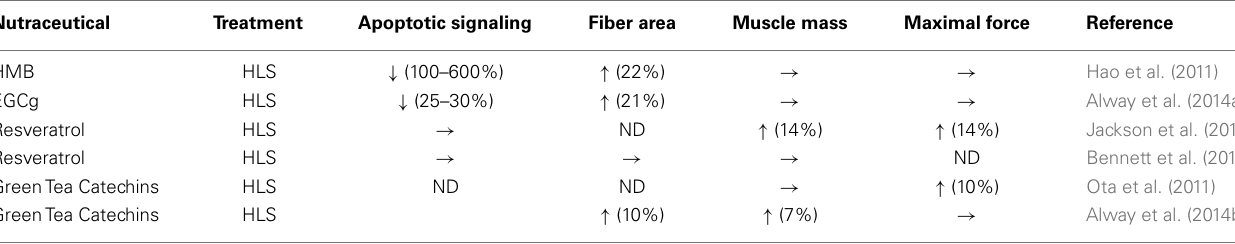
Table 1 | Summary of nutraceutical effect on apoptosis and muscle function in aging muscle during forced disuse . Nutraceutical